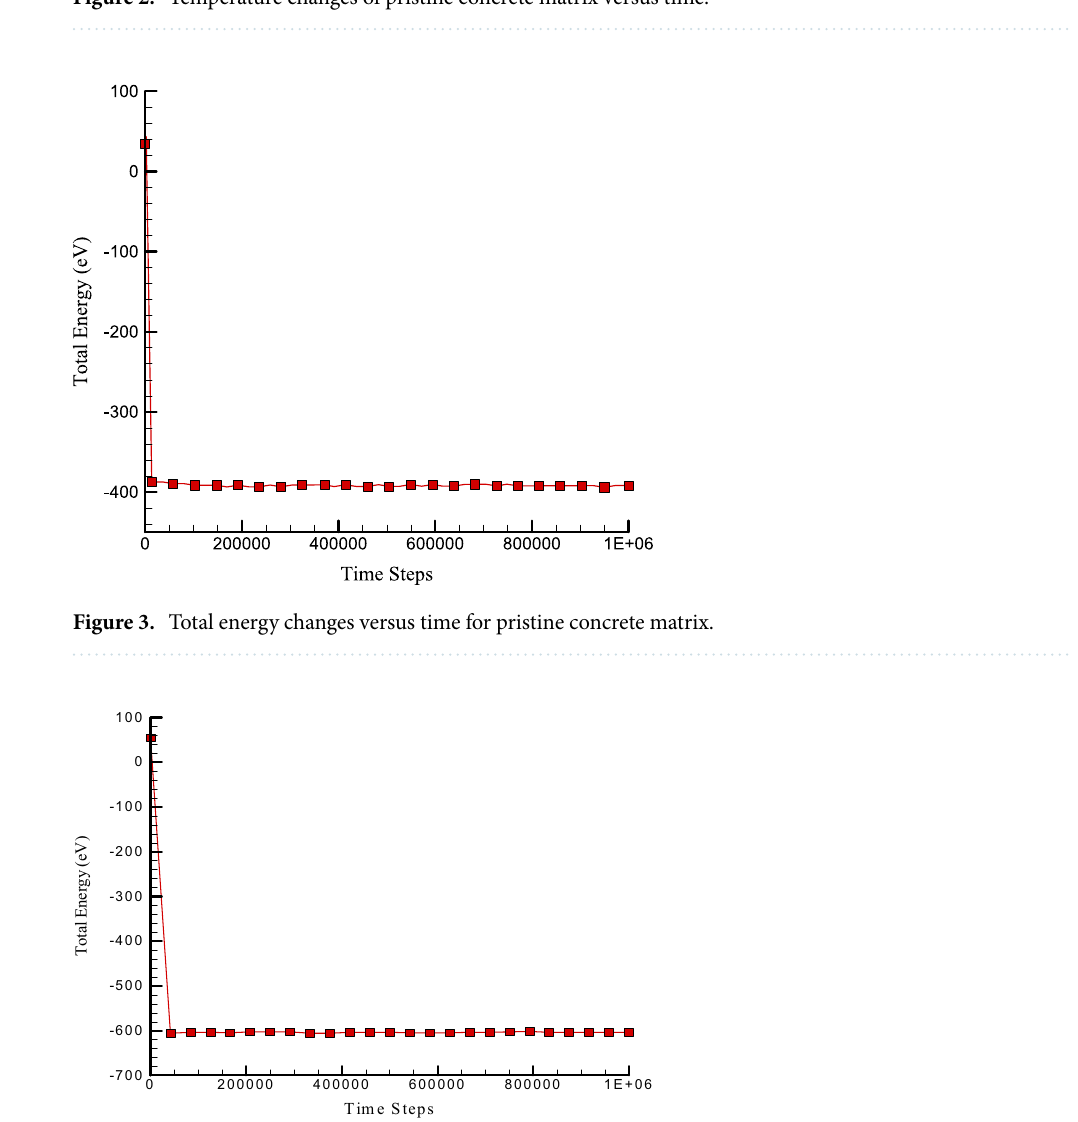
Figure 2. Temperature changes of pristine concrete matrix versus time.